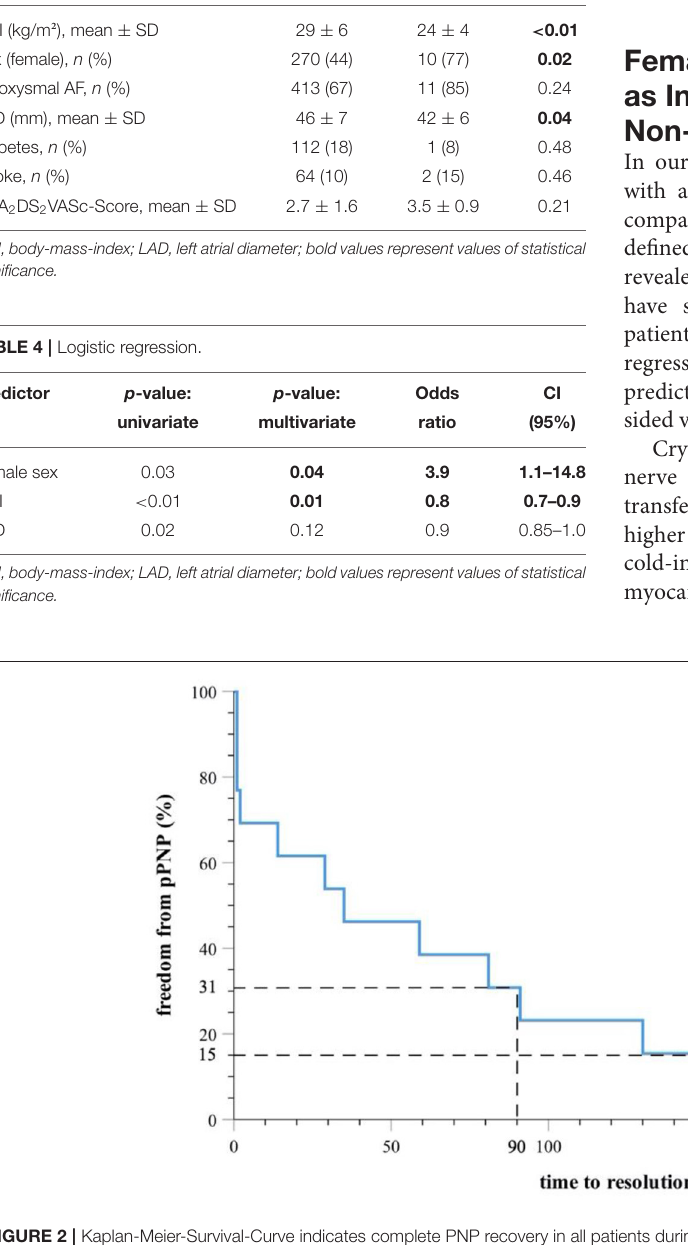
Frontiers in Cardiovascular Medicine |